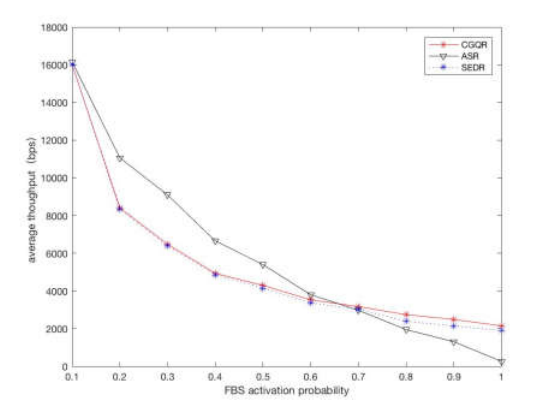
Figure 4. Femtocell network capacity with